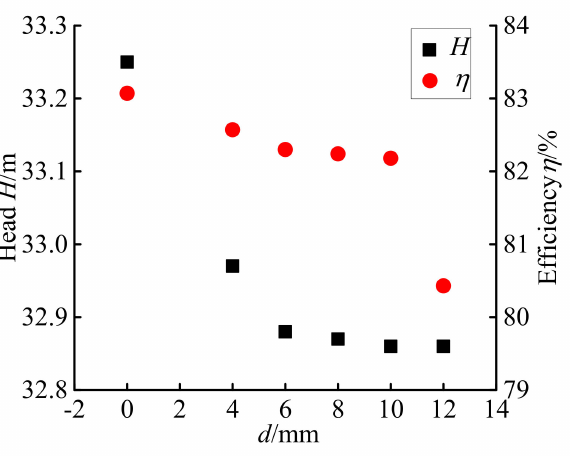
Figure 5. Simulation results of external characteristic parameters of centrifugal